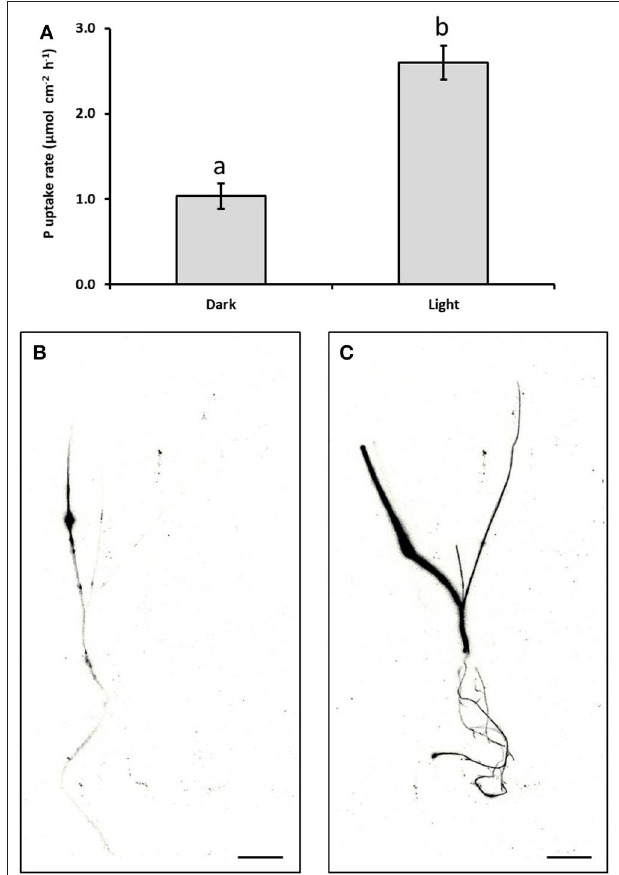
FIGURE 3 | Effect of photosynthetic light upon the uptake rate of foliar P into Triticum aestivum leaves. Panel (A) shows the average uptakes rates of 33 P into the whole plant ( n = 3). Panels (B,C) show images of the distribution of 33 P in whole wheat seedlings displaying the mobility of 33 P following its application to a 16 mm 2 area of the bottom surface of one leaf over 16h when placed in either the light [Panel (B) ] or dark [Panel (C) ]. Scale bars are 2cm. Lower case letters mark values significantly different from each other at the p < 0.05 level (unpaired t -test). Error bars are standard errors of the mean